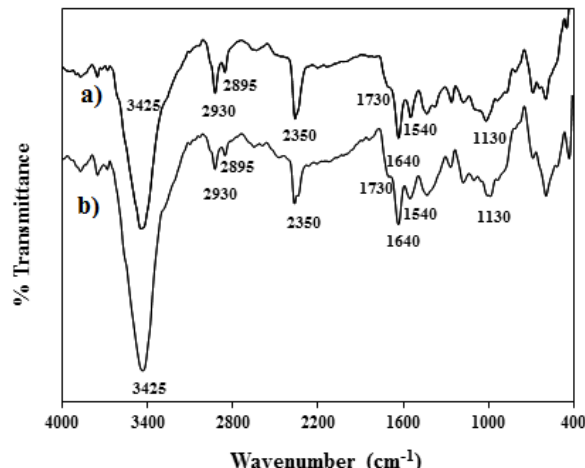
Fig. 2. FTIR spectra of MWCNTs (a) before and (b) after functionalization